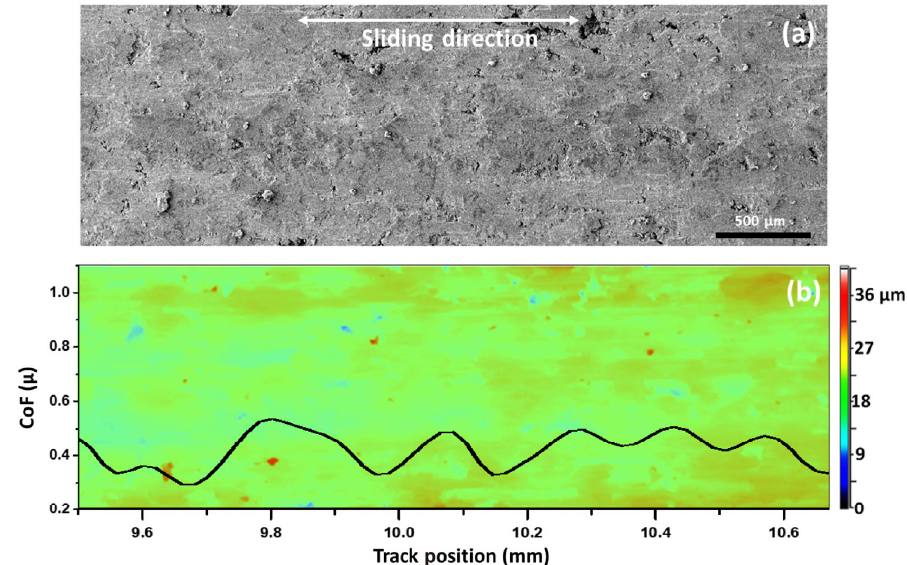
Fig. 5 Instantaneous CoF with surface profilometry in Regime I at 200